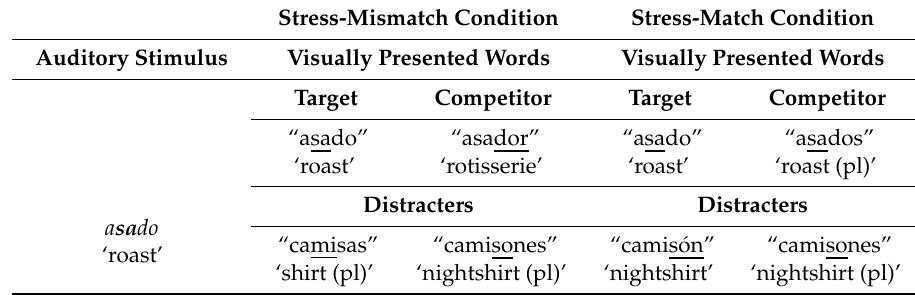
Table 2. Example stimuli in the non-cognate condition.